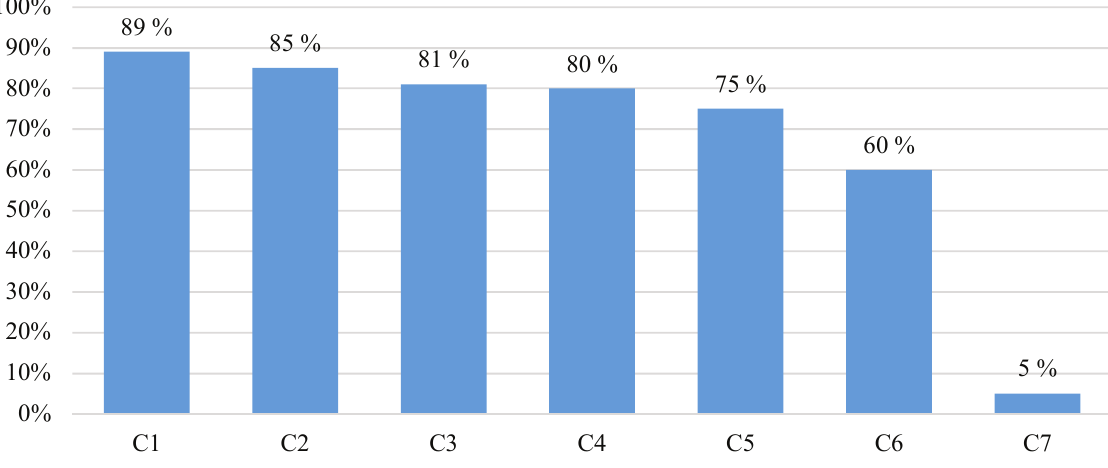
Fig. 6. Advantages of prestigious HEI graduates: C1 – high level of theoretical knowledge, C2 – practical skills, C3 – high level of competitiveness in the labour market, C4 – possession of information technology needed to perform